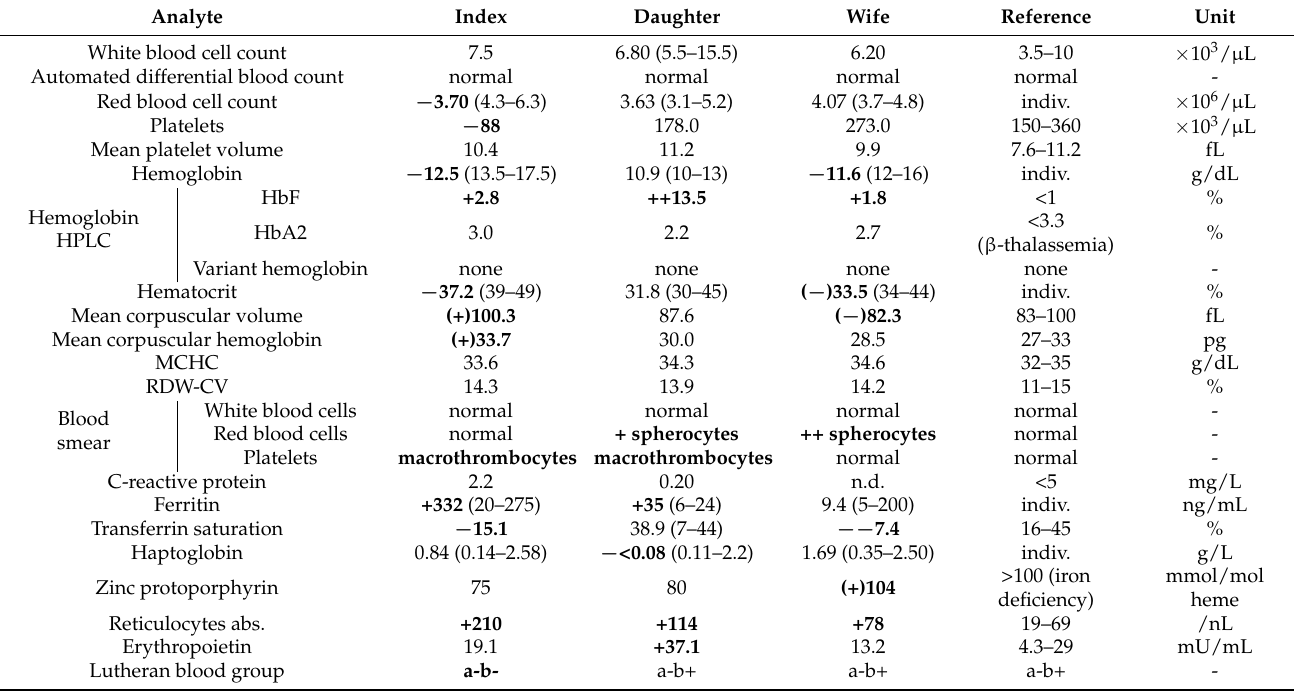
Table 1. Laboratory characteristics of the index patient (male, age 36), his daughter (female, age 4), and his wife (female, age